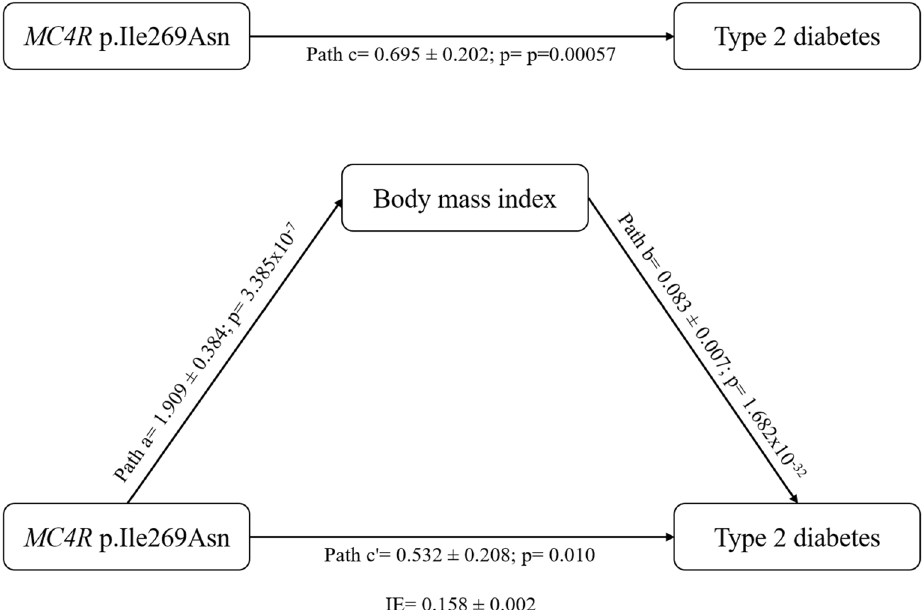
Figure 1. Simple mediation model evaluating the effect of body mass index as a mediator of the association between MC4R p.Ile269Asn and type 2 diabetes (% of mediation = 22.7%, Sobel test: z = 4.584; p = 4.55 × 10 –6 ). Path a, effect of MC4R p.Ile269Asn on body mass index (data is expressed as beta value ± standard error analyzed by a linear regression model adjusted for age and sex); Path b, effect of body mass index on type 2 diabetes (data is expressed as Log Odds Ratio ± standard error analyzed by a logistic regression model controlled for MC4R p.Ile269Asn, and adjusted for age and sex); Path c, total effect of MC4R p.Ile269Asn on type 2 diabetes (data is expressed as Log Odds Ratio ± standard error analyzed by a logistic regression model adjusted for age and sex); Path c ′ , effect of MC4R p.Ile269Asn on type 2 diabetes (data is expressed as Log Odds Ratio ± standard error analyzed by a logistic regression model controlled for body mass index, and adjusted for age and sex); IE, indirect effect of MC4R p.Ile269Asn on type 2 diabetes (data is expressed as the product of path a and path b); % of mediation is computed as IE divided by path